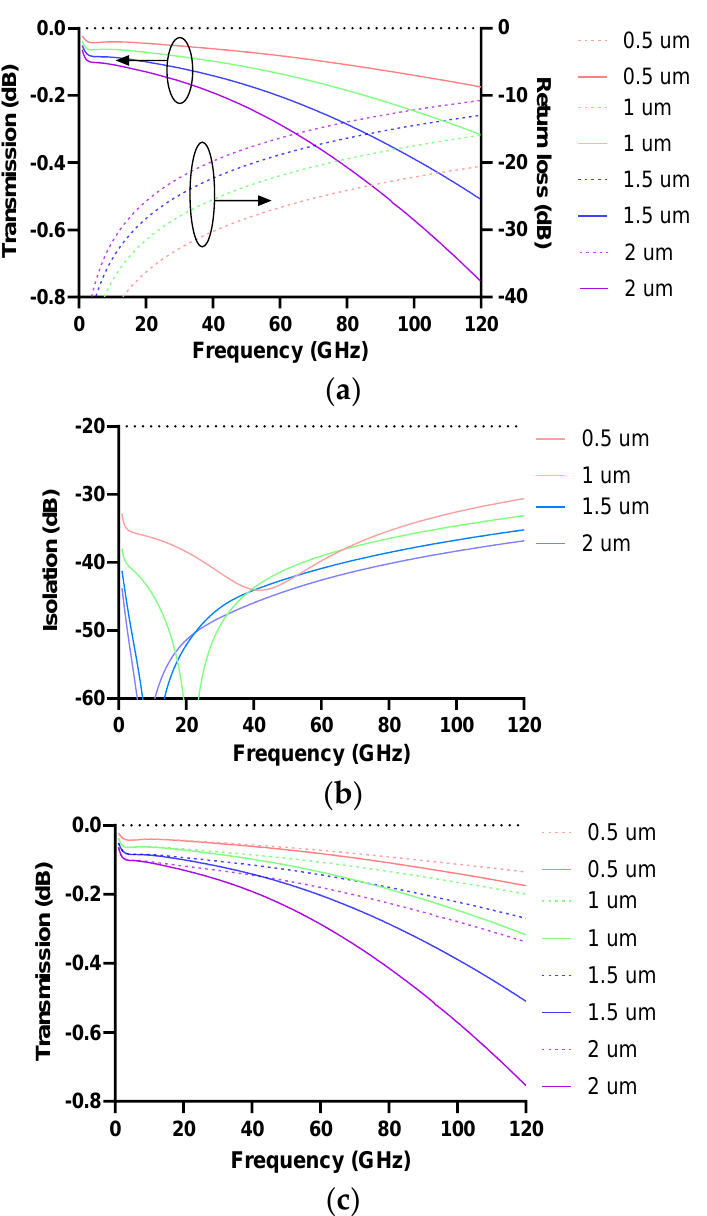
Figure 6. PCM switch simulation results vs. microheater width w h ( a ) on-state, ( b ) off-state, and ( c ) on-state with dashed lines showing the insertion loss after removing the mismatch loss. The PCM semi-T switch, a four-port device with two operational states, ‘thru’ and ‘turn’, is achieved by combining several infrastructure elements, 8 × SPST, a crossover (Figure 7a), 4 × T-junction (Figure 7b), and 2 × 90 ◦ turn (Figure 7c). Each infrastructure el- ement must be designed and optimised with the best performance for wideband operation, as per our RF MEMS article [39–41]. Figure 7d shows the simulated model with the PCM switches grouped according to their operational state, thru and turn, with the full semi-T switch size of only 170 µ m × 170 µ m. Figure 7c,d shows the simulation results of the thru-state and turn-state. From the simulation RF performance, it can be concluded that the semi-T switch achieves the best wideband performance, unmatched by other technologies. Both states have better than 1 dB insertion loss, and better than 20 dB return loss, and the disconnected ports have better than 44 dB isolation from DC to 120